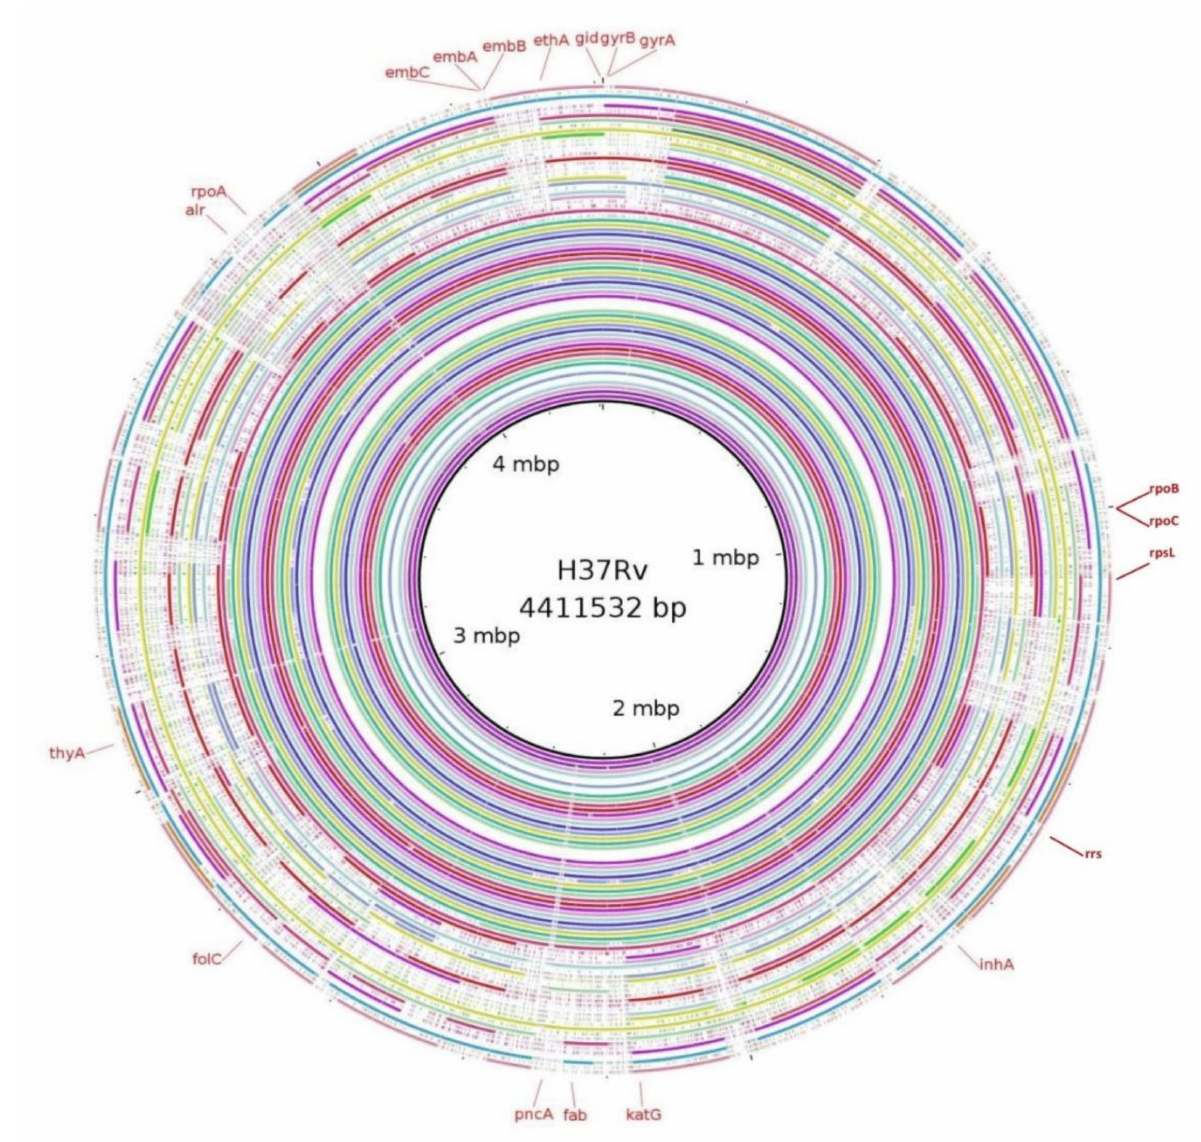
Figure 2. Variant densities of the 65 sequenced genomes against M. tuberculosis H37Rv using BRIG